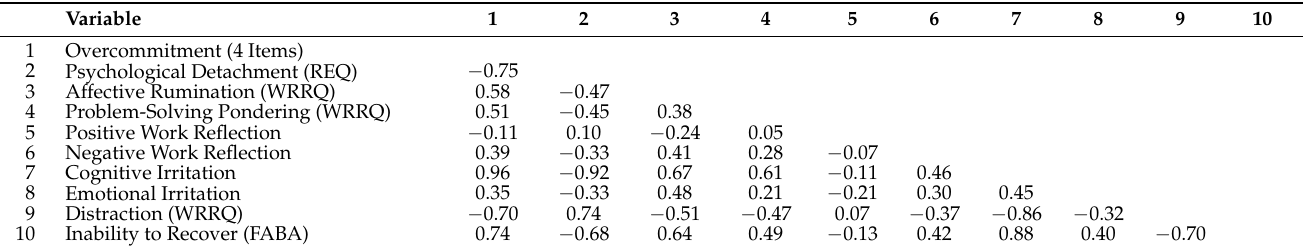
Table 6. Estimated Covariances among Factor in the Confirmatory Factor Analysis (Sample